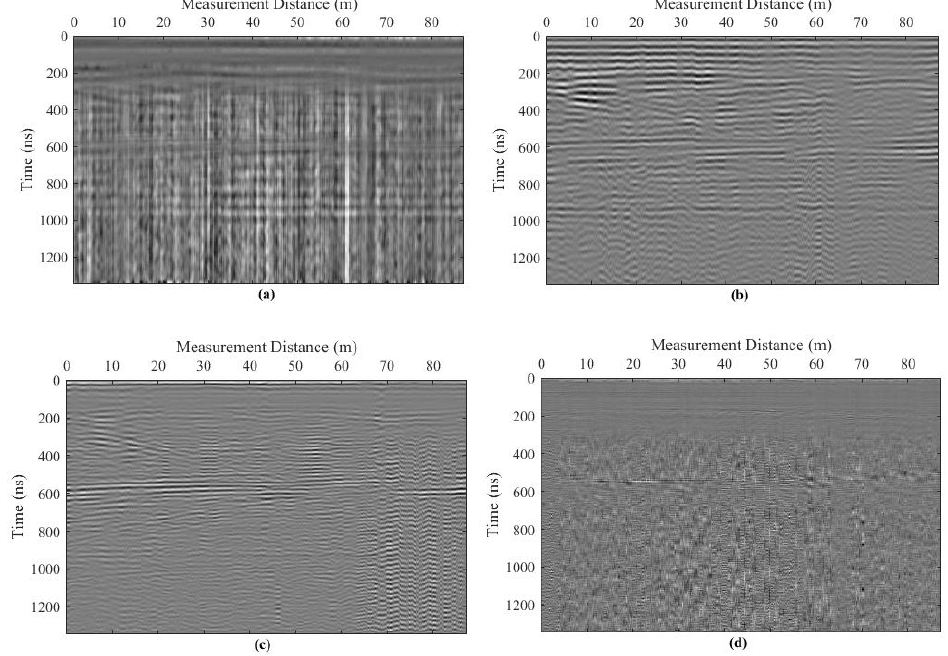
Figure 15. The derived IMF-slices of the field dataset using VMD. ( a – d ) show the IMF-slice 1–4 respectively.